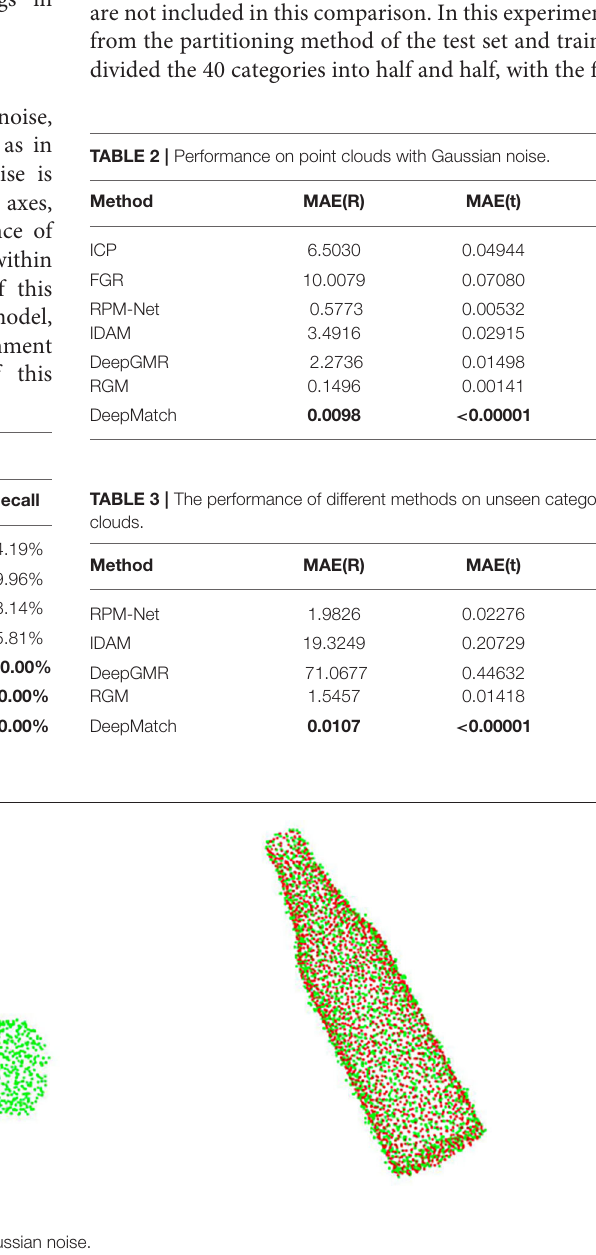
Frontiers in Neurorobotics |